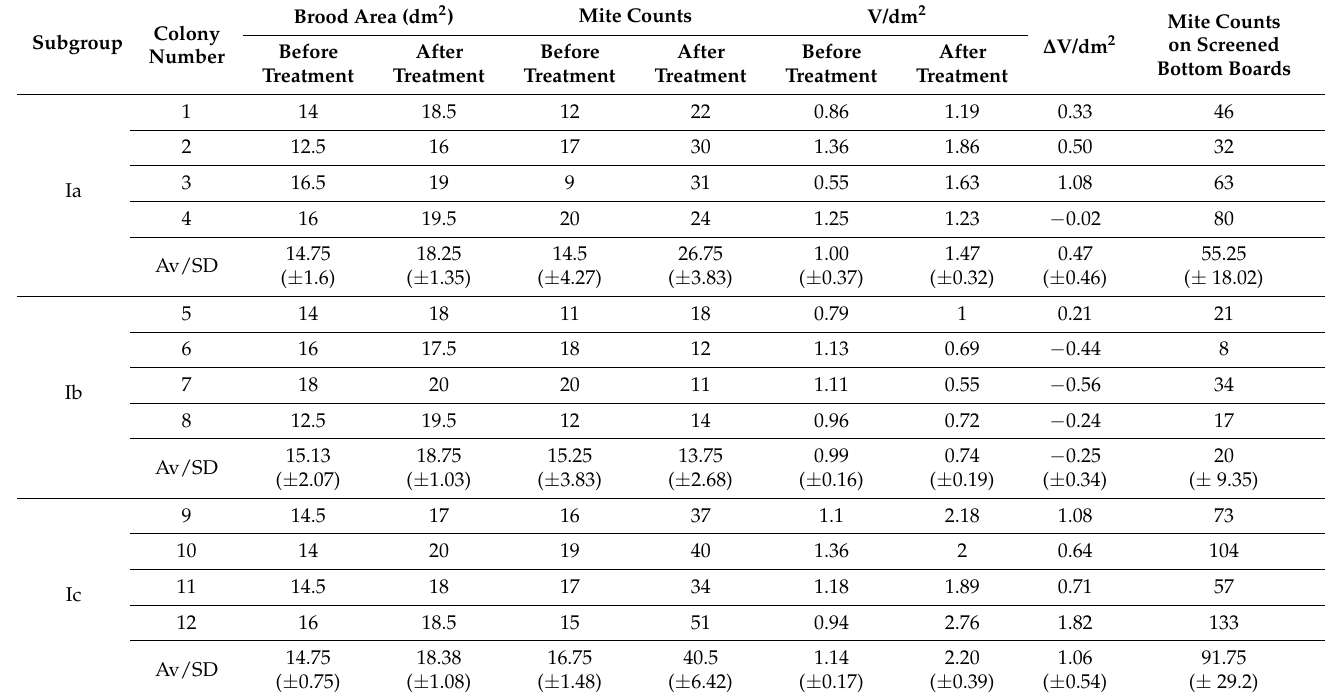
Table 2. Brood area (dm 2 ) and mite counts in group